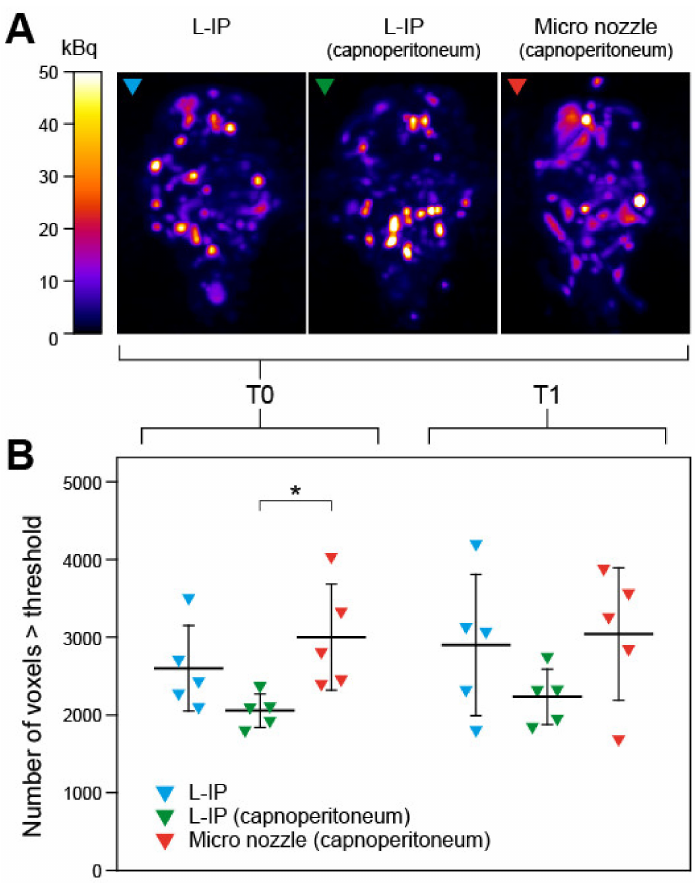
Figure 5. SPECT analysis of the intraabdominal distribution pattern of Tc-99 m-labeled doxorubicin. ( A ) Representative SPECT scans of mice in anterior-posterior maximum intensity projection (MIP) at T0. The NIH Image Fire2 pallete was used and range was set to 0–50 kBq. ( B ) Distribution, represented by number of voxels exceeding a threshold activity of 5 kBq (T0) or 4 kBq (T1; see Materials and Methods). Higher values correspond to a more uniform distribution pattern. Triangles represent individual mice ( n = 5), thick horizontal lines are means, error bars represent standard deviations. L-IP, liquid intraperitoneal injection; T0, 20 min after administration of doxorubicin; T1, T0 + 1 h. Statistical significance is indicated: *, p <